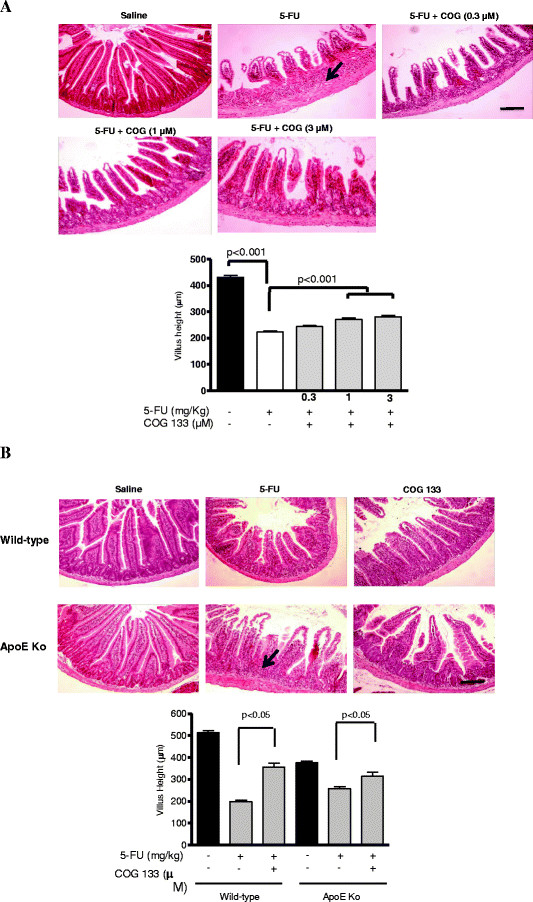
A. Representative histology and villus height from H-E stained-proximal intestine (X100) of Swiss mice challenged by 5-FU-induced intestinal mucositis (450 mg/kg via i.p., single dose, and treated with the apoE mimetic peptide COG 133 (0.3, 1, and 3 μM, via i.p., 12/12 h, vol. 10 μl/g) or 0.9% saline (i.p.). Scale bar = 100 μm. B. Representative histology and villus height from H-E stained-proximal intestine (X100) of C57BL6J ApoE knock-out and wild-type mice challenged by 5-FU-induced intestinal mucositis (450 mg/kg via i.p., single dose) and treated with the apoE mimetic peptide COG 133 (3 μM, via i.p., 12/12 h, vol. 10 μl/g) or 0.9% saline (i.p.). Scale bar = 100 μm. The arrow indicates a heavy inflammatory cell infiltrate in the submucosal tissue from the 5-FU-treated mice. Note reductions of inflamed tissue in apoE COG 133-treated groups, especially in the highest doses. Values represent mean ± SEM and were analyzed by one-way ANOVA and Bonferroni. At least 10 villi per animal were analyzed (n = 4 animals/group). Experimental mice were sacrificed on the fourth day post-challenge.